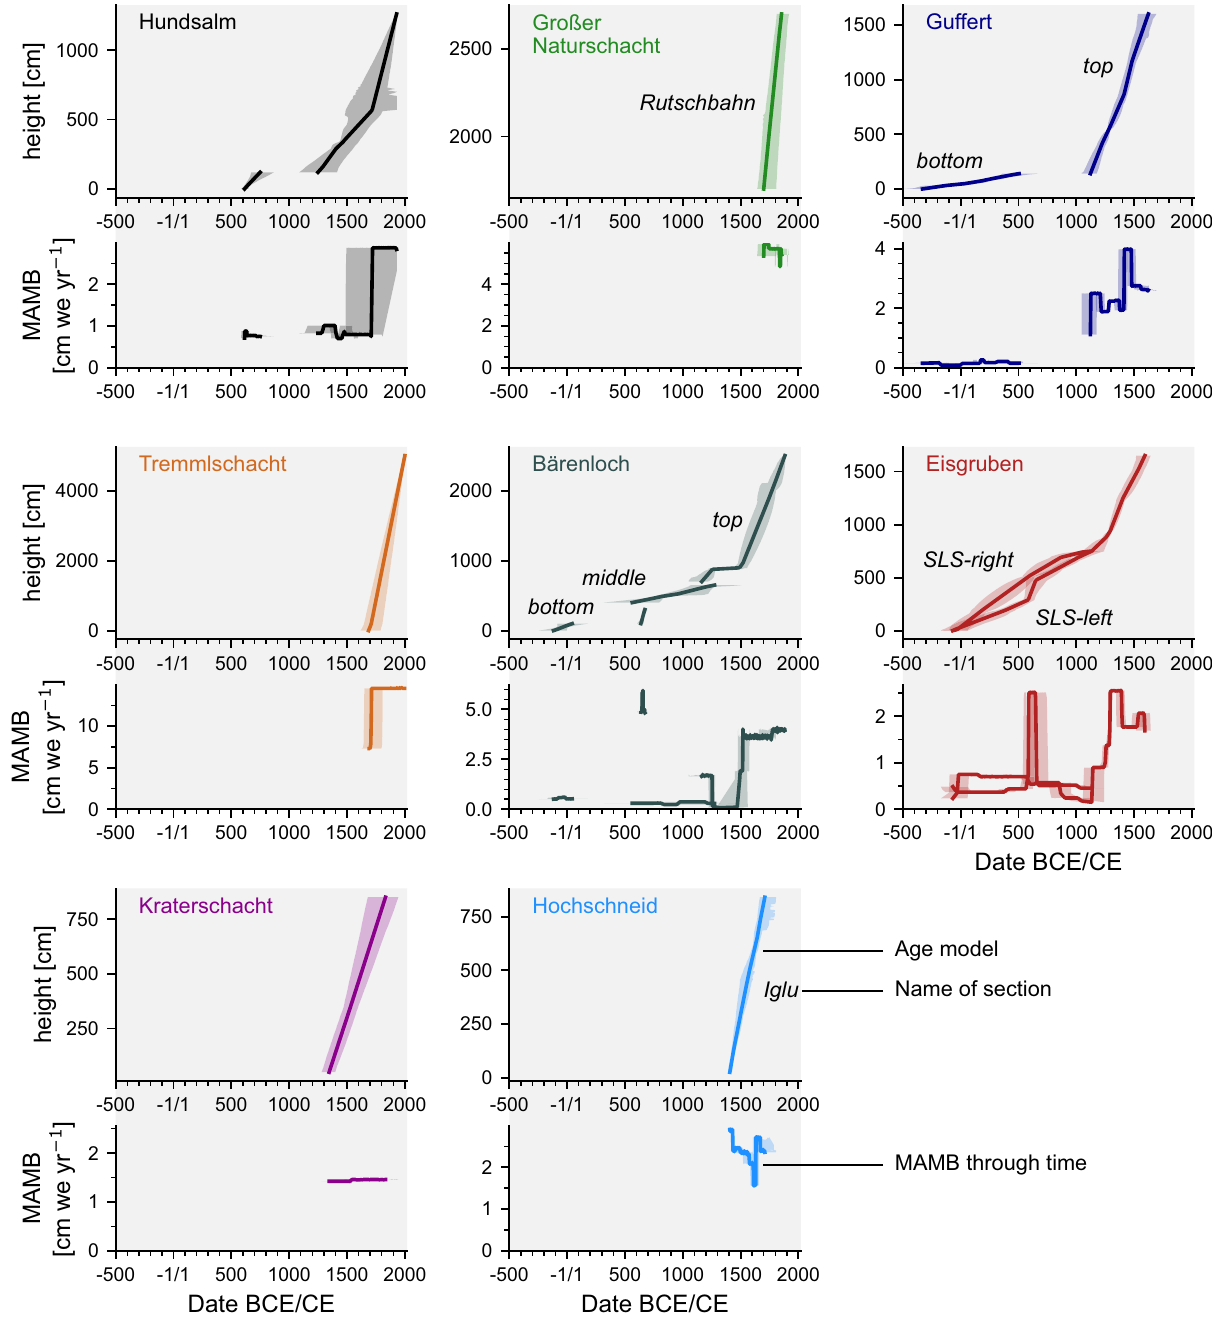
Figure 3. Summary of age-depth modelling and derived MAMB during the last 2.5 millennia all selected caves. Shaded areas denote the 95.6% confidence intervals of the respective age models. At Eisgruben, two sections covering the early part of the record, until Boundary III, were sampled, and thus, two age models and MAMB records were calculated for the relevant time